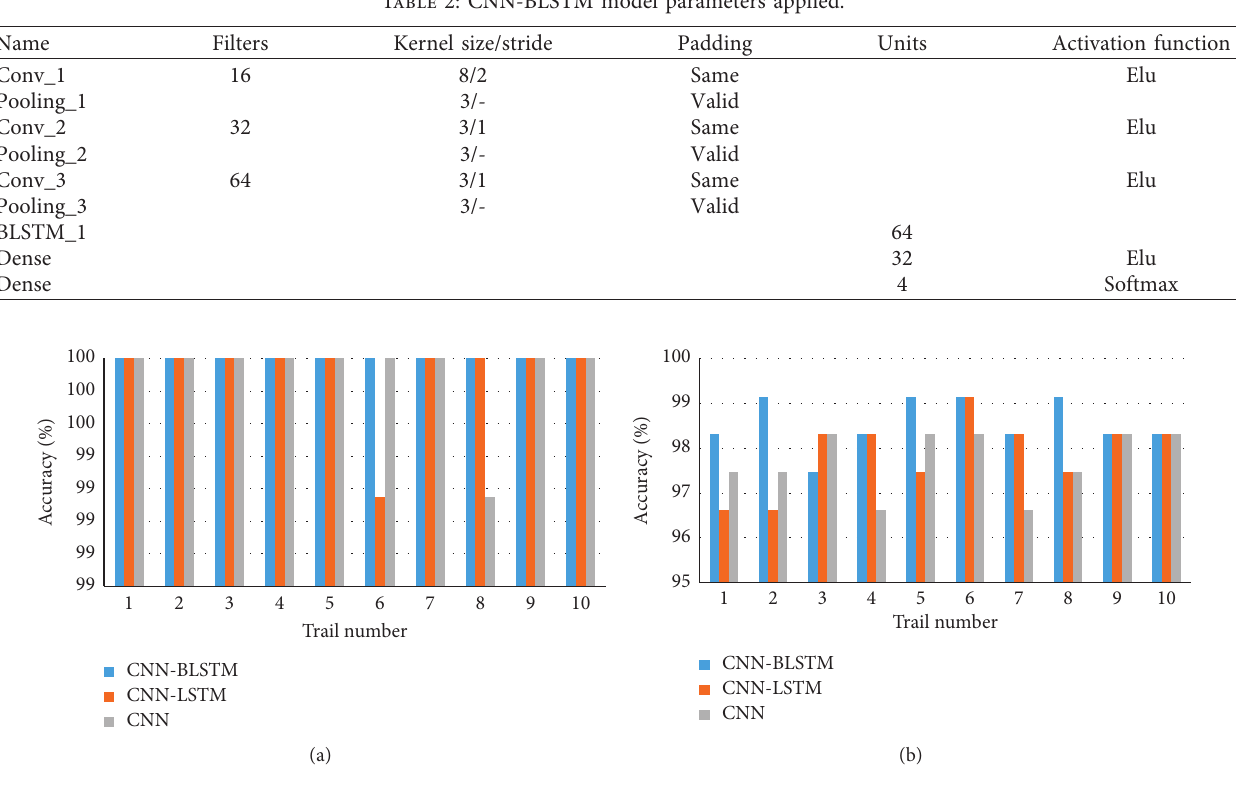
Figure 5: Classification test experiment results. (a) The experimental data is divided into 4 categories. (b) The experimental data is divided into 10 categories. Table 3: Dividing into 4 types of test diagnosis results.